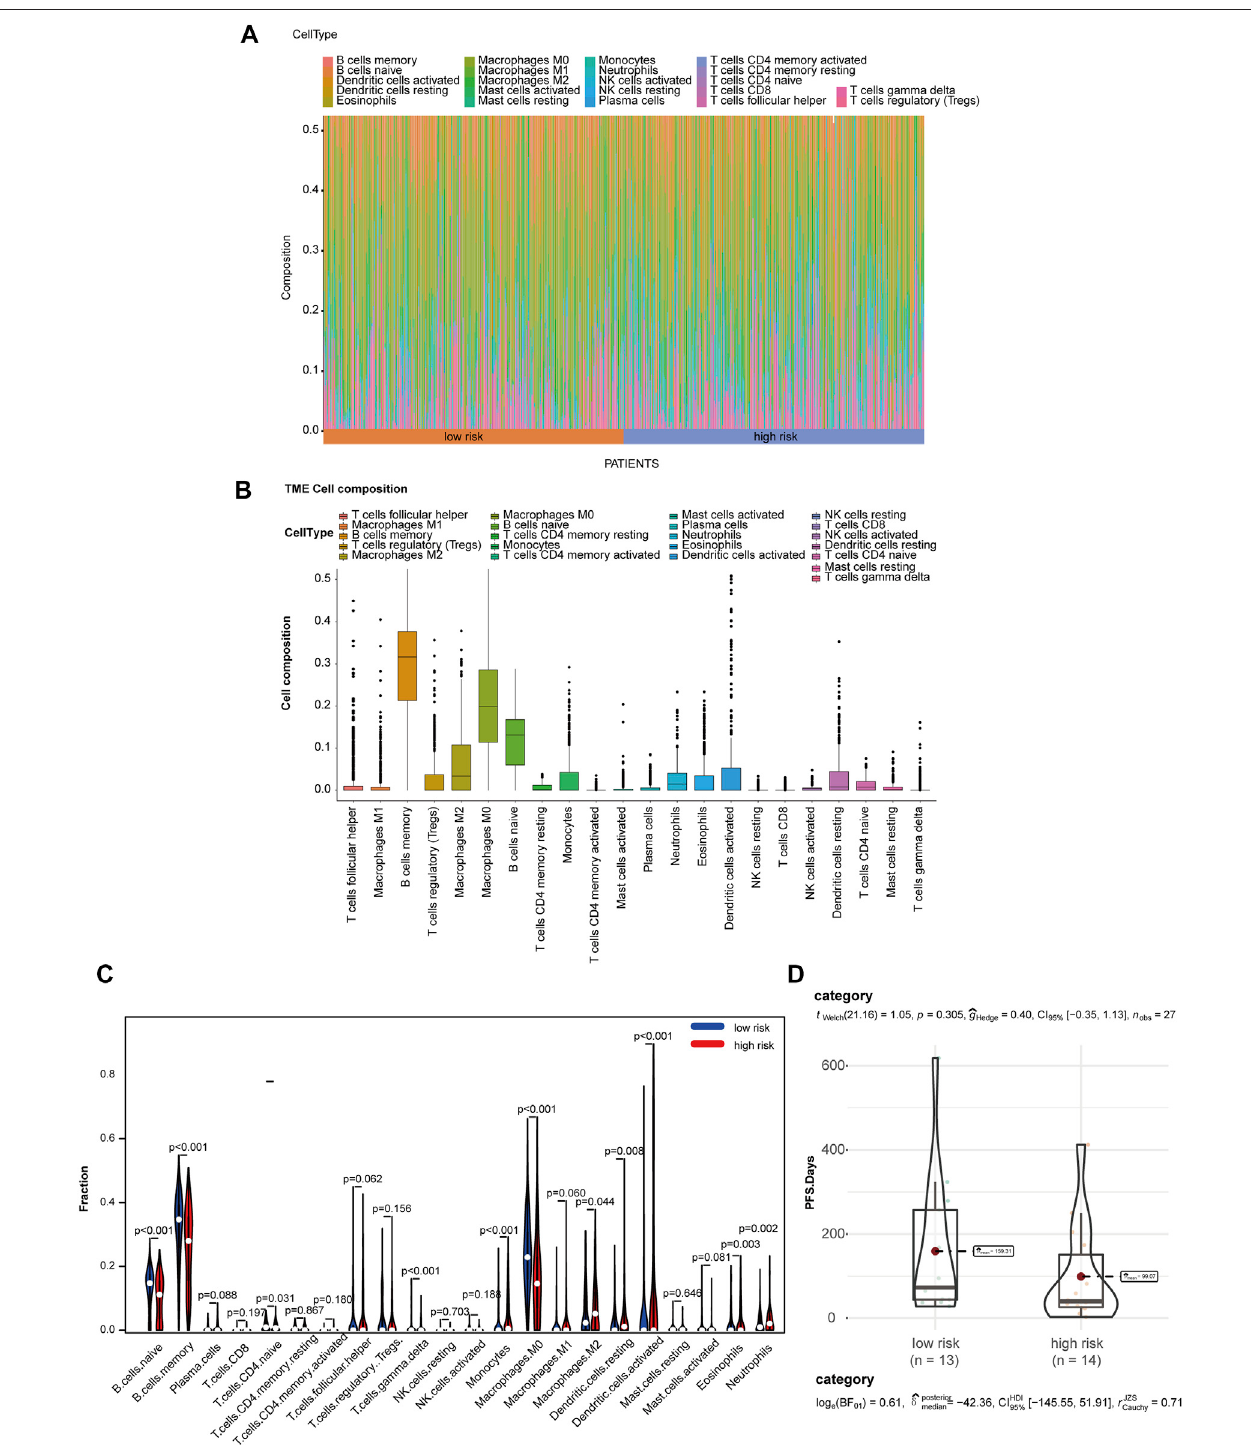
FIGURE 5 | MGRS was associated with TME immune cell in fi ltration. (A) Differential distribution of immune cells in each patient. (B) Differential distribution of immunecellsinallpatients. (C) Differentialdistribution ofimmunecellsinlow-andhigh-riskgroups. (D) Box/violinplotsshowingthedifferentiationoftheIC50ofanti-PD- 1/L1 antibodyin low- and high-risk groups.